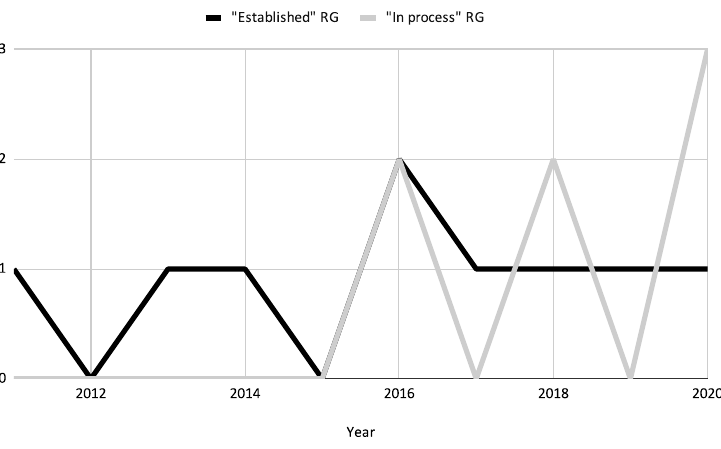
Figure 2. Evolution of the groups and lines of research .